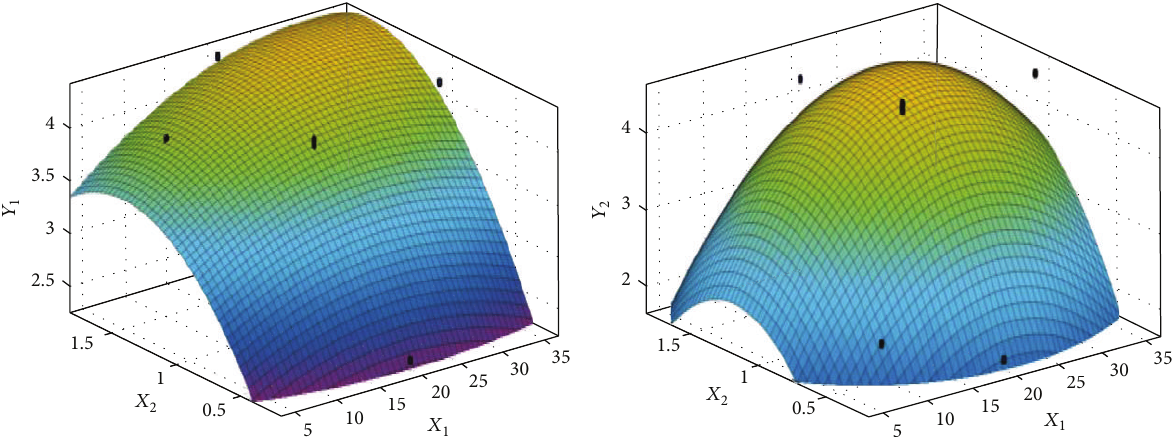
Figure 5: Response surface for flexural strength, 𝑌 1 , and split tensile strength, 𝑌 2 .